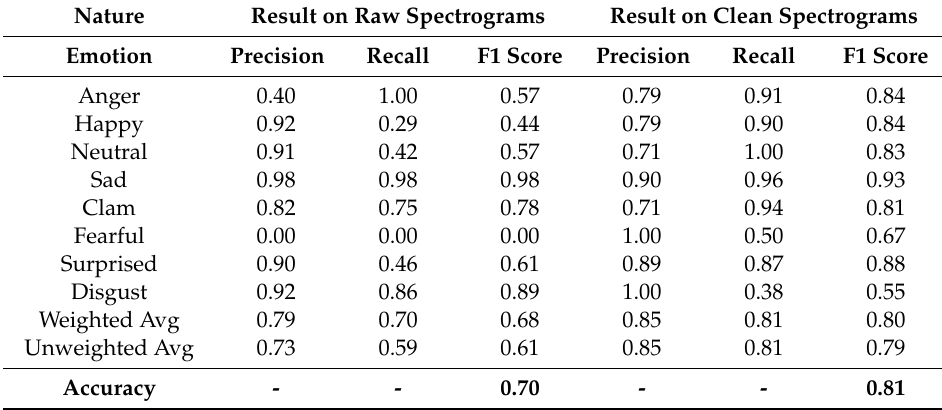
Table 3. Training performance of the proposed DSCNN model on raw and clean spectrograms using RAVDESS.